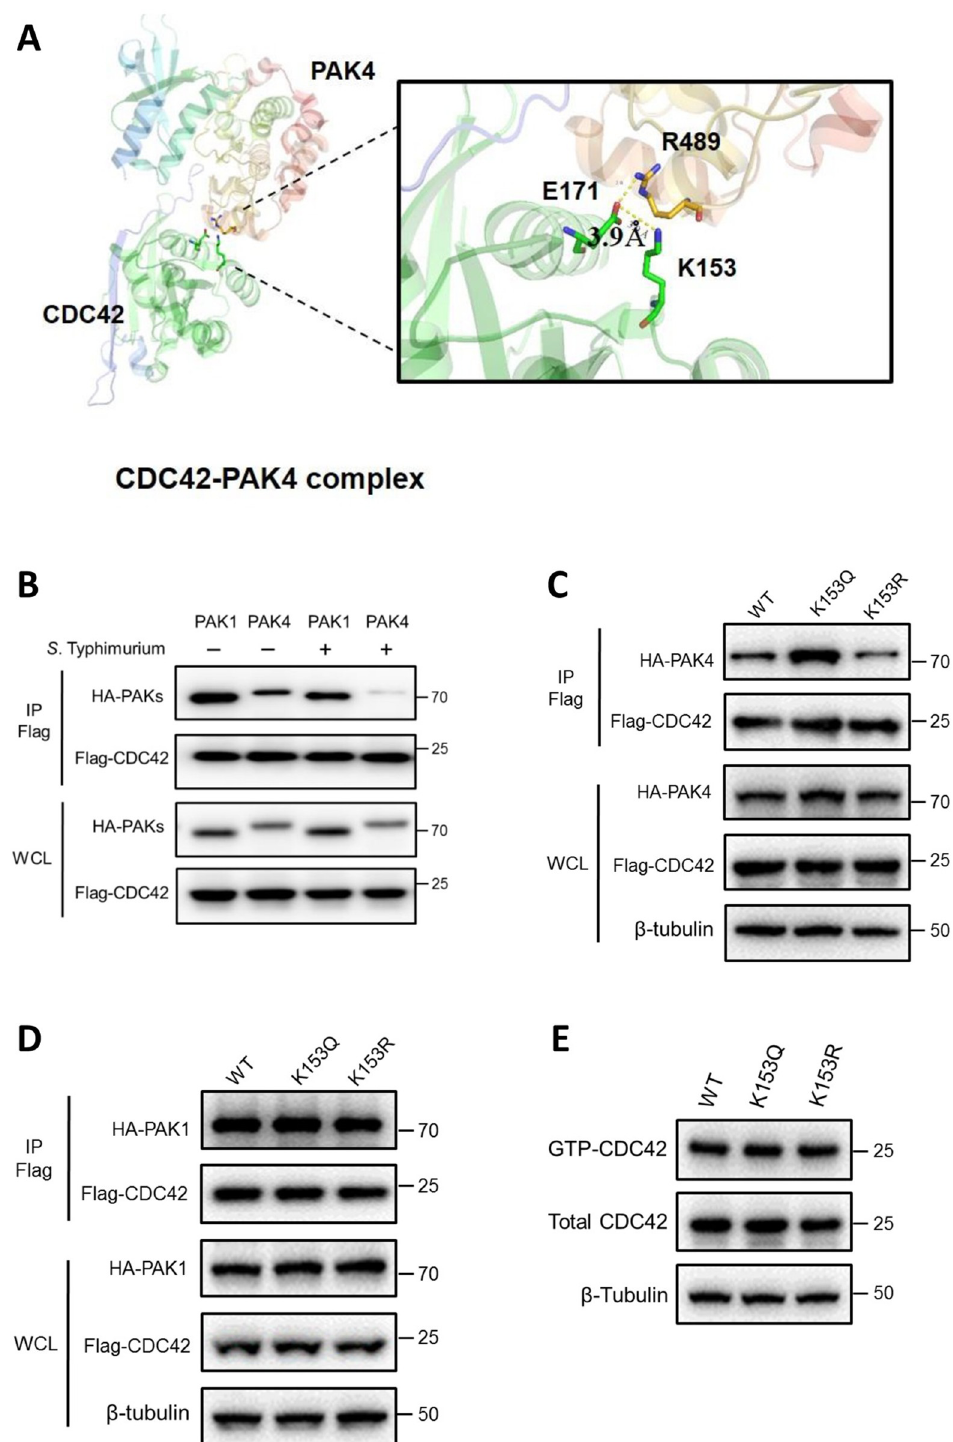
Fig 2. Acetylation of K153 is essential for CDC42 interaction with PAK4. (A) Ribbon diagram showing the structure of CDC42-PAK4 (PDB-ID: 5UPK). (B) S . Typhimurium infection drastically decreased the binding between CDC42 and PAK4. Flag-CDC42 was co-transfected with HA-PAK4 or HA-PAK1 into HEK293T cells for 48 h, followed by S . Typhimurium infection for 1 h. Protein interactions was analyzed by immunoprecipitation (IP) with anti-Flag antibody and followed by WB. K153R mutant attenuated the interaction between CDC42 and PAK4. Flag-